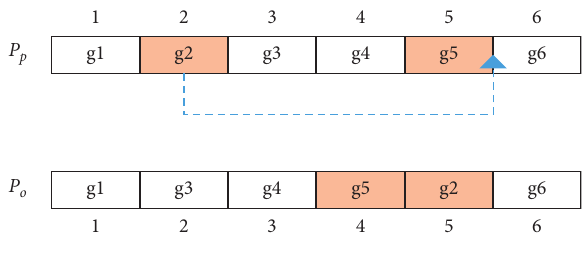
Figure 7: Schematic diagram of backward